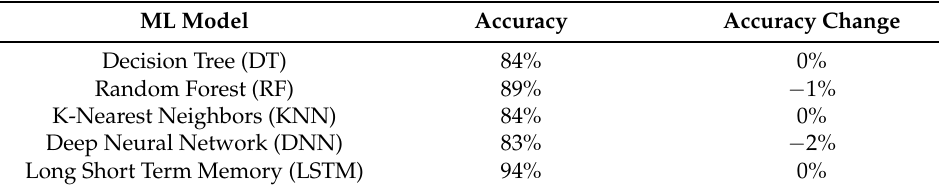
Table 5. Accuracies of ML classifiers for charging speed classification with 10% GWN.